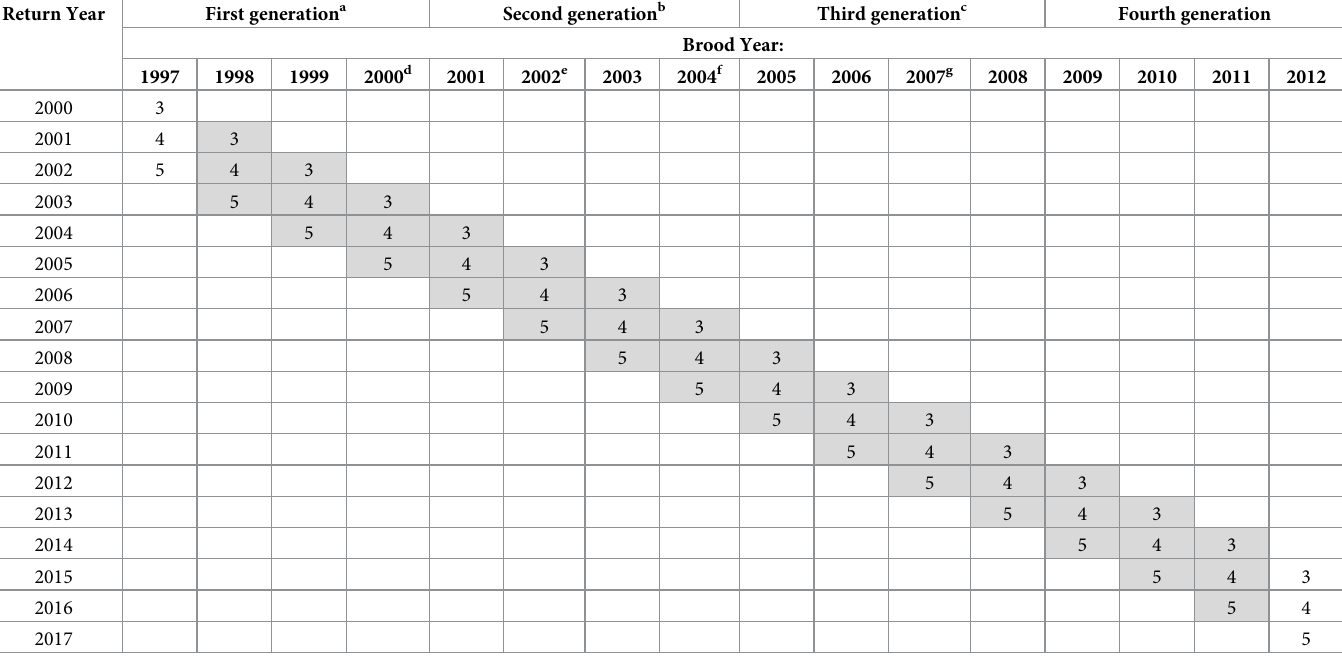
Table 1. Chronology of development of hatchery ancestry for Yakima River spring Chinook salmon through the first four generations of Cle Elum Supplementa- tion and Research Facility (CESRF) operation. First generation a Second generation b Third generation c Fourth generation Brood